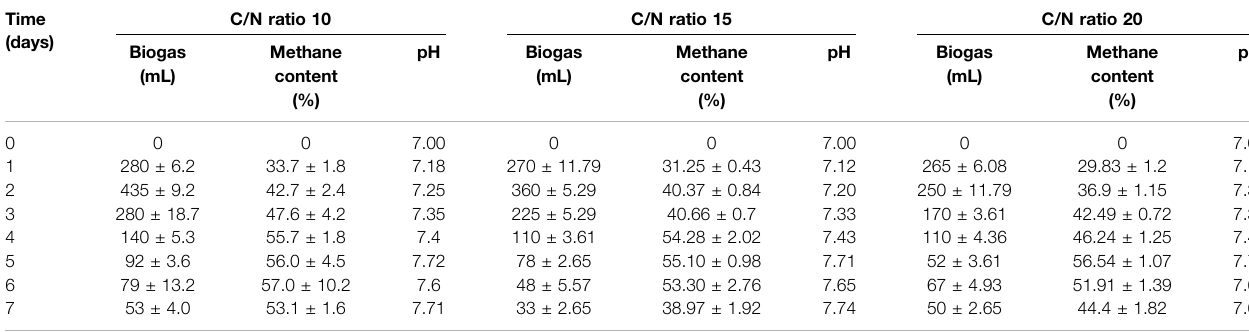
TS-AD, Two-stage anaerobic digestion.